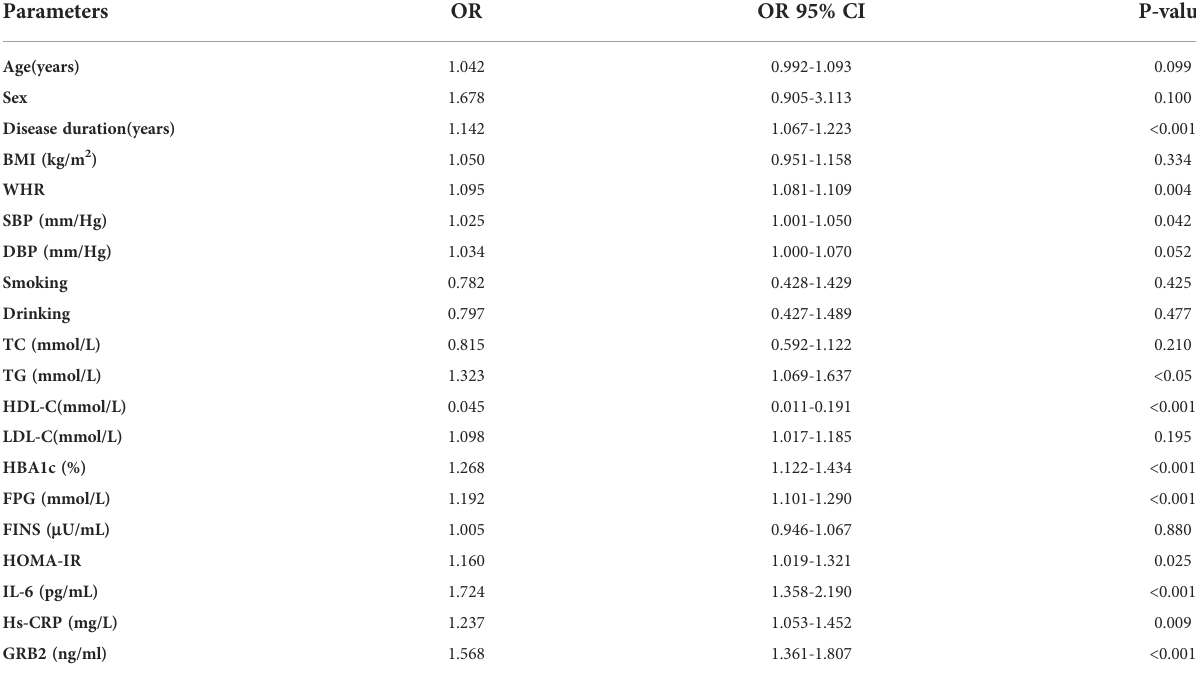
TABLE 6 Correlation of serum GRB2 levels with T2DM combined with CAS (univariate logistic regression). Parameters